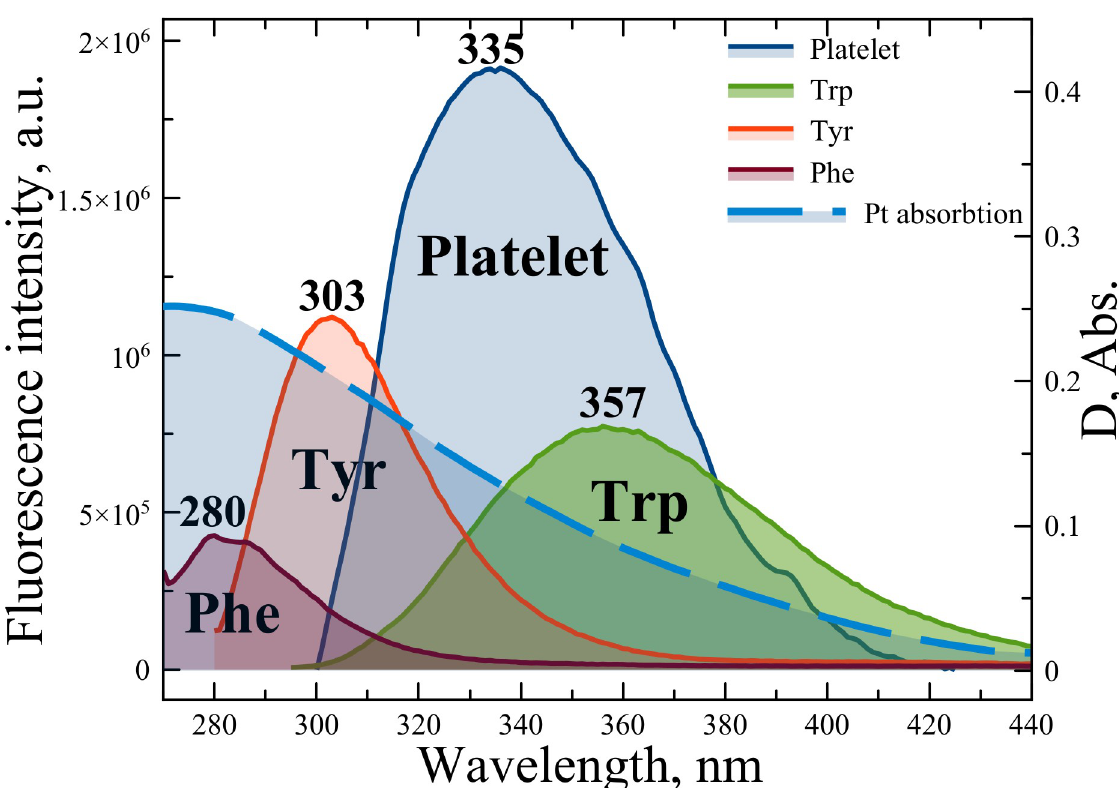
Fig 7. Absorption spectra of Pt NPs (blue dashed line), platelets (blue solid line), Trp (green solid line), Tyr (red solid line) and Phe (purple solid line) fluorescence spectra.